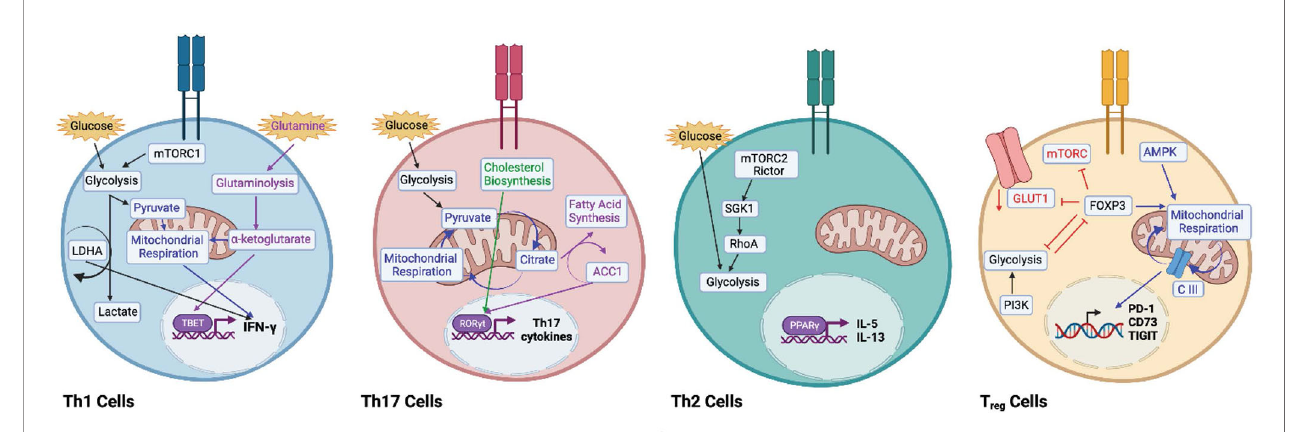
FIGURE 2 | Metabolic remodelling to promote Th helper T cell subsets. Th1 cells engage in glycolysis (black arrows) and aerobic respiration (blue arrows) to support interferon (IFN)- g expression. Lactate dehydrogenase (LDHA) has been shown to promote IFN- g expression. Inhibition of mTORC1 decreases IFN- g expression. Glutaminolysis (purple arrows) via ⍺ -ketoglutarate promotes TBET expression. Th17 cells use both glycolysis (black arrows) and oxidative phosphorylation (blue arrows) to secrete Th17-associated cytokines. Acetyl-CoA carboxylase 1 (ACC1) promotes ROR g t expression (purple arrows), and intermediates of cholesterol biosynthesis (green arrows) support the ROR g t program. Th2 cells are supported by high levels of glycolysis. The mTORC2-Rictor complex supports the Th2 lineage via SGK1 and RhoA (black arrows). Peroxisome proliferator- activated receptor (PPAR)- g has been shown to promote IL-5 and IL-13. Regulatory T (T reg ) cells are supported by mitochondrial respiration (blue arrows), as AMPK expression drives fatty acid oxidation and oxidative phosphorylation. Complex III of the electron transport chain supports the expression of immunosuppressive genes like PD-1, CD73, and TIGIT. Expression of FOXP3 promotes AMPK expression and inhibits expression of mTORC1, GLUT1, and glycolysis (red arrows). Activation of PI3K drives glycolysis and decreases Treg suppression (black arrows). Glycolysis and FOXP3 reciprocally regulate each other. Image created with